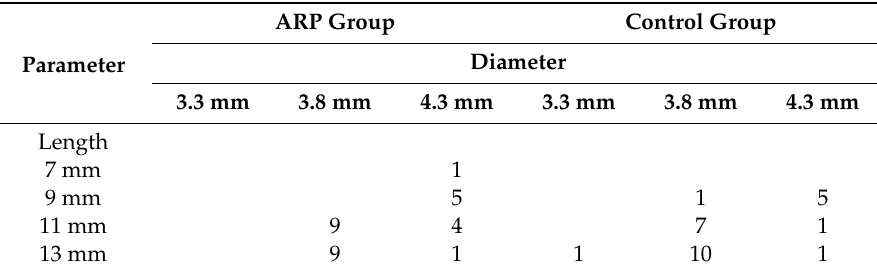
Table 6. Distribution of the lengths and the diameters of the inserted implants.